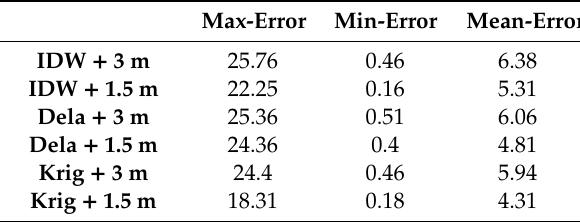
Figure 11. Positioning error with the different interpolation methods (inverse distance weighting (IDW) and Delaunay) and interpolation densities (3 and 1.5 m) without a near relation. Table 1. Positioning error statistics without near relation.